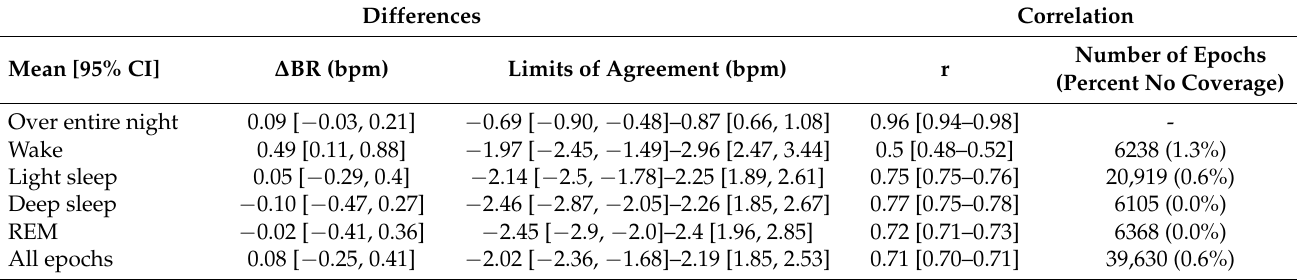
Table A3. Summary of correlation and Bland–Altman metrics for BR for all participants. The number of epochs refers to epochs that were included in the analysis of each group. No coverage refers to the percentages of epochs for which the smart bed did not produce a BR reading, but a PSG BR reading was available. A positive (or negative) bias indicated that the smart bed underestimated (or overestimated) the PSG-derived